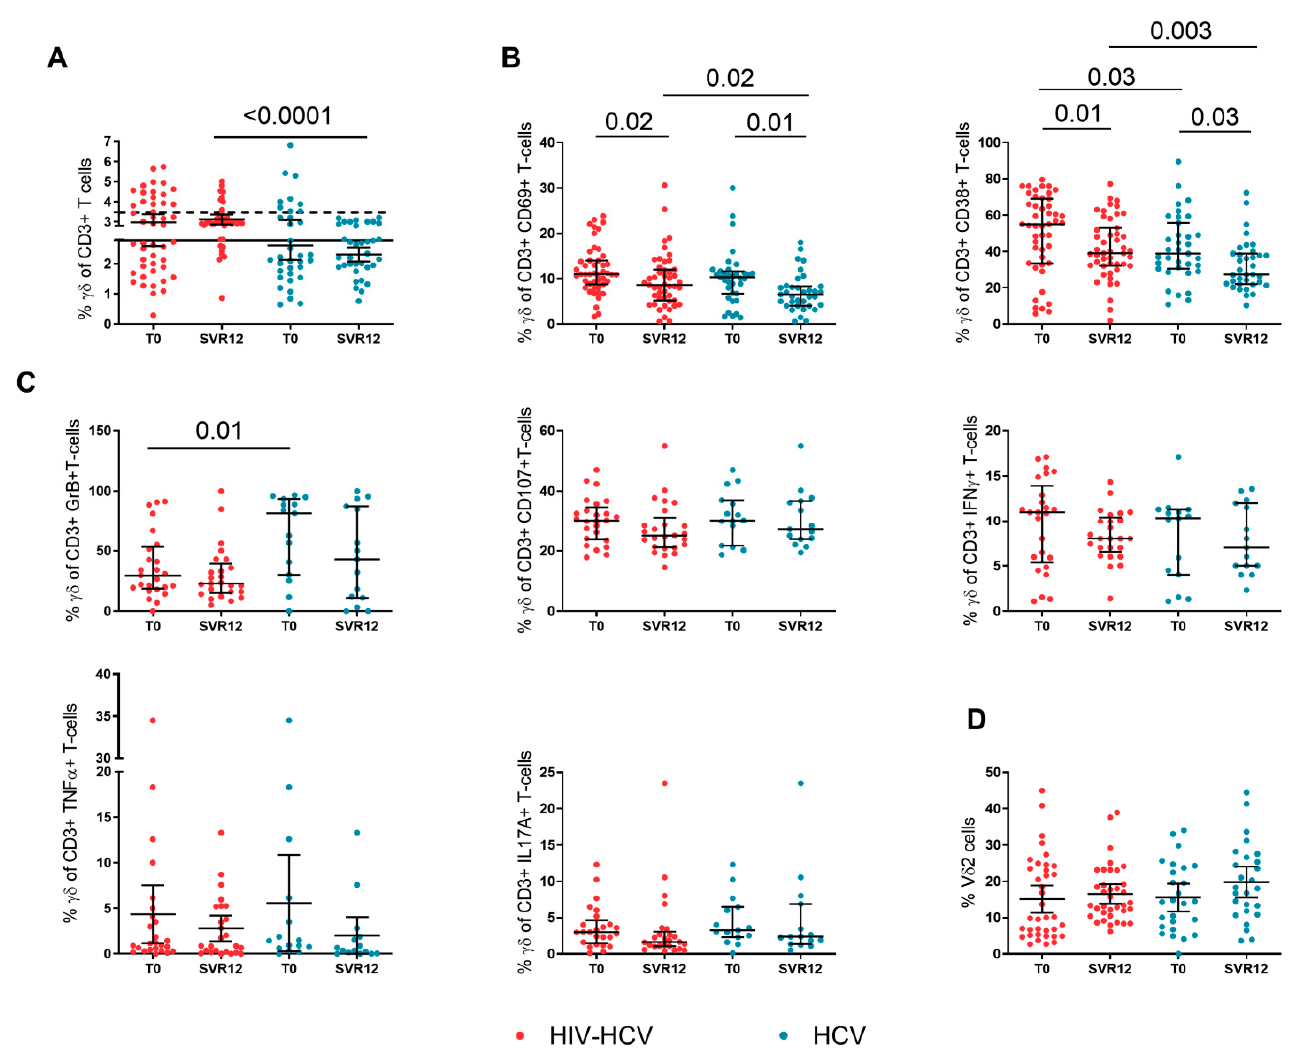
Figure 1. γδ T-cell phenotype, activation, function, and V δ 2 T-cells in the HIV-HCV co-infected and HCV mono-infected individuals that were undergoing DAA treatment. ( A ) Frequencies of γδ T-cells in the HIV-HCV co-infected and HCV mono-infected individuals prior and following DAA treatment. Wilcoxon matched-pairs test ( n = 40 and n = 35) and Mann–Whitney test. For this experiment, the HIV mono-infected individuals ( n = 15; bold line) and healthy controls ( n = 10; dotted line) are also shown. The HCV mono-infected individuals showed significantly lower γδ T-cell frequencies after DAA treatment than the healthy controls (2.34% [IQR: 1.89–2.89] vs. 3.44% [IQR: 2.4–4.61] p -value = 0.006). ( B ) Frequencies of activated CD69+ and CD38+ γδ T-cells in the HIV- HCV co-infected and HCV mono-infected individuals prior and following DAA treatment. Wilcoxon matched-pairs test ( n = 47 and n = 35) and Mann–Whitney test. ( C ) Frequencies of Granzyme B, CD107a, IFN- γ , TNF- α , and IL1–7A producing γδ T-cells in the HIV-HCV co-infected and HCV mono-infected individuals prior and following DAA treatment. Wilcoxon matched-pairs test ( n = 25 and n = 15) and Mann–Whitney test. ( D ) Frequencies of V δ 2 T-cells in the HIV-HCV co-infected and HCV mono-infected individuals prior and following DAA treatment. Wilcoxon matched-pairs test ( n = 31 and n = 26) and Mann–Whitney